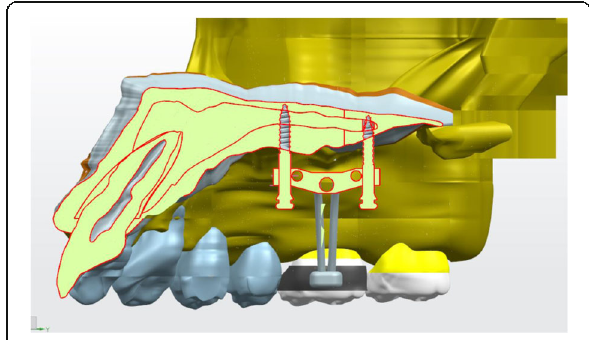
Fig. 10 Cortical bone thickness dissimilarity on